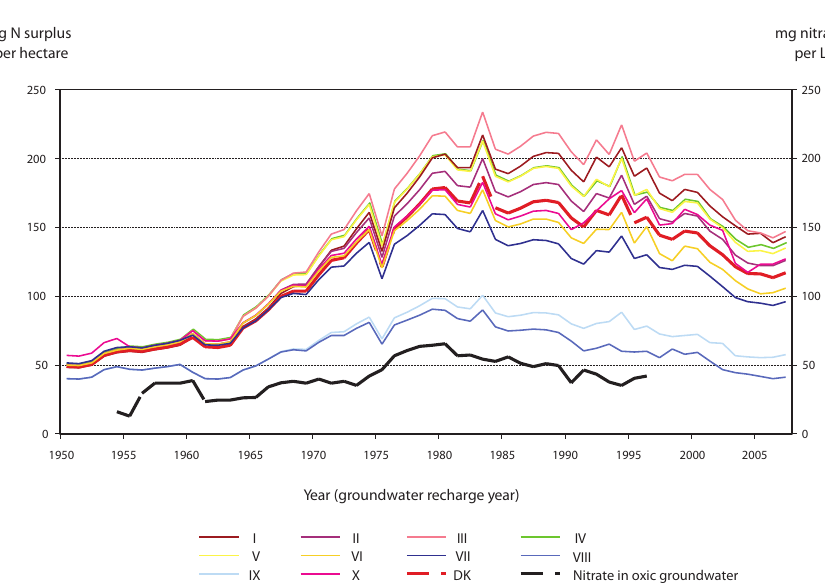
Fig. 3. Time series of agricultural N surplus in 10 different geo-regions of Denmark, and nitrate in oxic groundwater versus recharge age (CFC-age) at an annual mean level. The nitrate concentrations in oxic groundwater are shown as a 5-yr moving average curve. The location of the 10 geo-regions is seen in Fig.